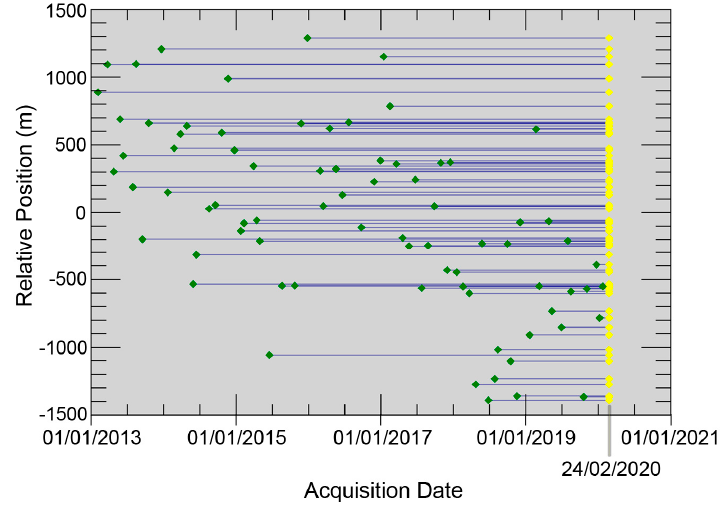
Figure 5. COSMO-SkyMed images. Time–baseline plot, which provides the normal baseline (y axis) and the input acquisition dates (x axis). Each acquisition is represented by a diamond associated to an ID number. Valid acquisitions are shown in green color and Master acquisition in yellow color.